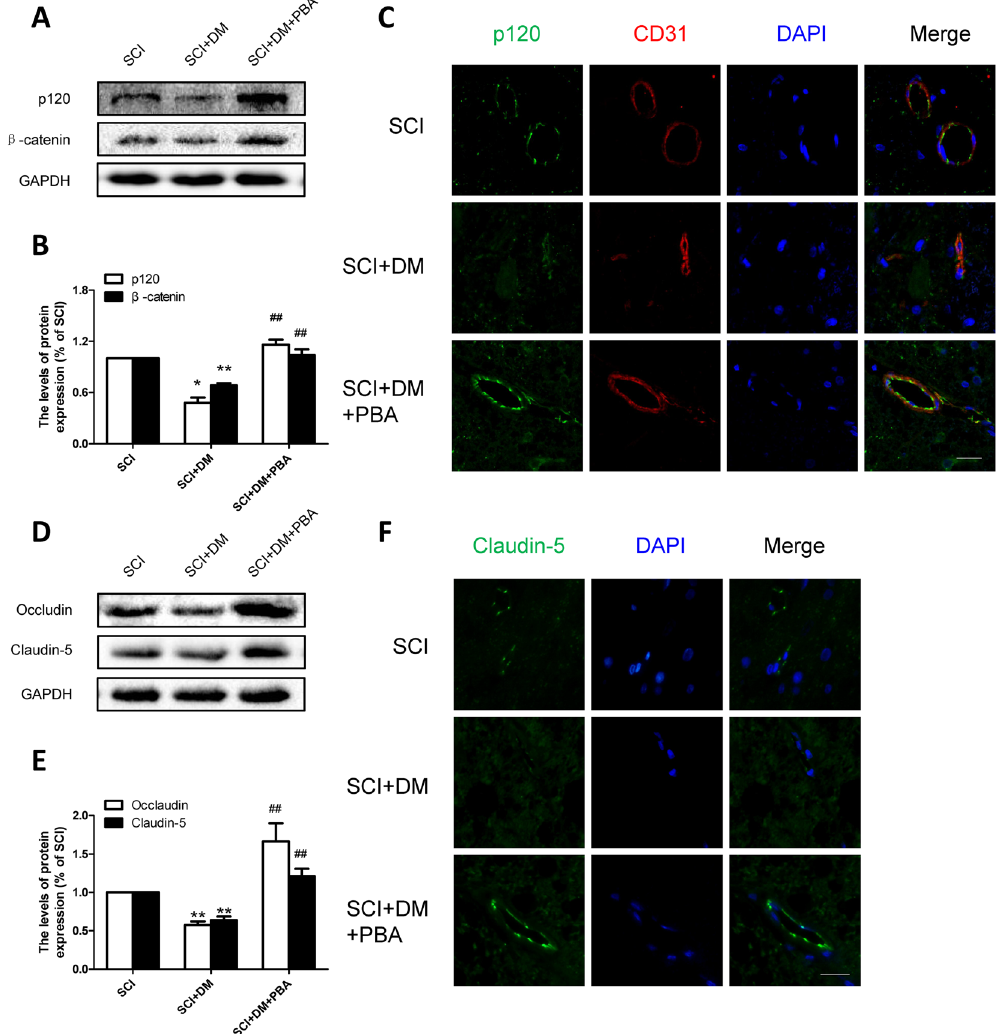
Figure 8. Inhibiting ER stress prevents the loss of TJ and AJ proteins in diabetic rats after SCI. ( A , B ) Western blot and quantification of p120 and β -catenin in each group, n = 6. ( C ) Immunofluorescence staining of p120 and CD31 in each group, n = 4. Scale bar = 10 μ m. ( D , E ) Western blot and quantification of Occludin and Claudin-5 in each group, n = 6. ( F ) Immunofluorescence staining of Claudin-5 in each group, n = 4. Scale bar = 10 μ m. * p < 0.05, ** p < 0.01 vs SCI group, ## p < 0.01 vs SCI + DM